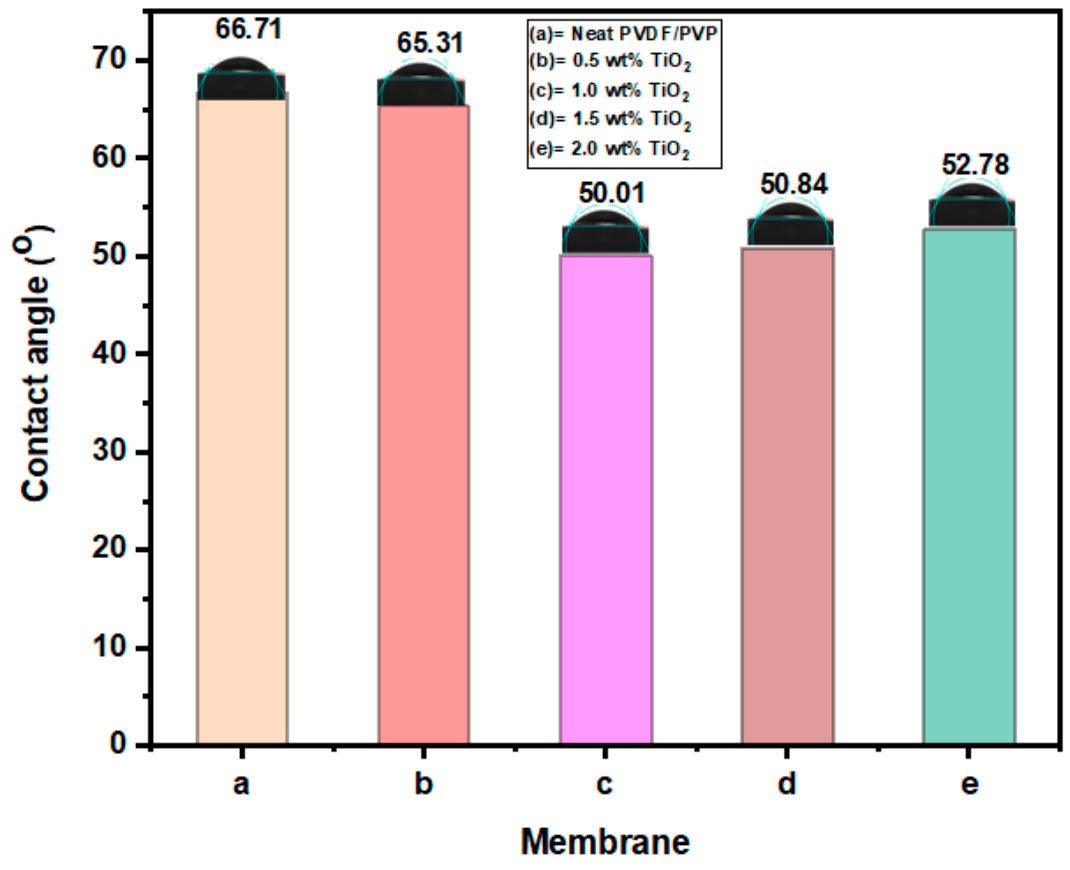
Figure 3. The contact angles of neat PVDF-PVP ( a ) and membranes modified with TiO 2 ( b ), ( c ), ( d ) and ( e ).